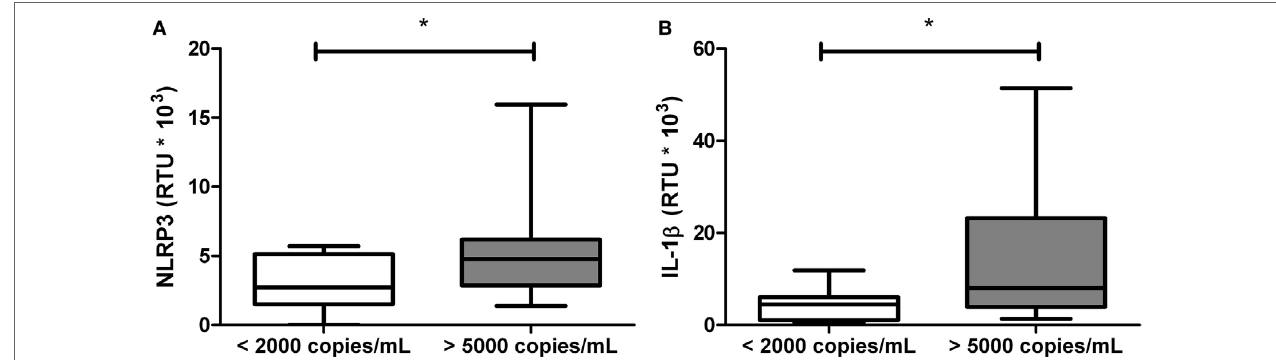
FigUre 3 | Increased mRNA levels of NLRP3 and IL-1 β in patients with high viral loads. Total RNA was obtained from human immunodeficiency virus type 1-infected individuals, classified according to the viral load and quantified by real-time PCR: (a) NLRP3 and (b) IL-1 β . β -Actin was used as the constitutive gene to normalize the RNA content. The statistical comparison was made using the Mann–Whitney U with a 95% confidence level. Significant differences are represented in the upper part of this figure (* p <